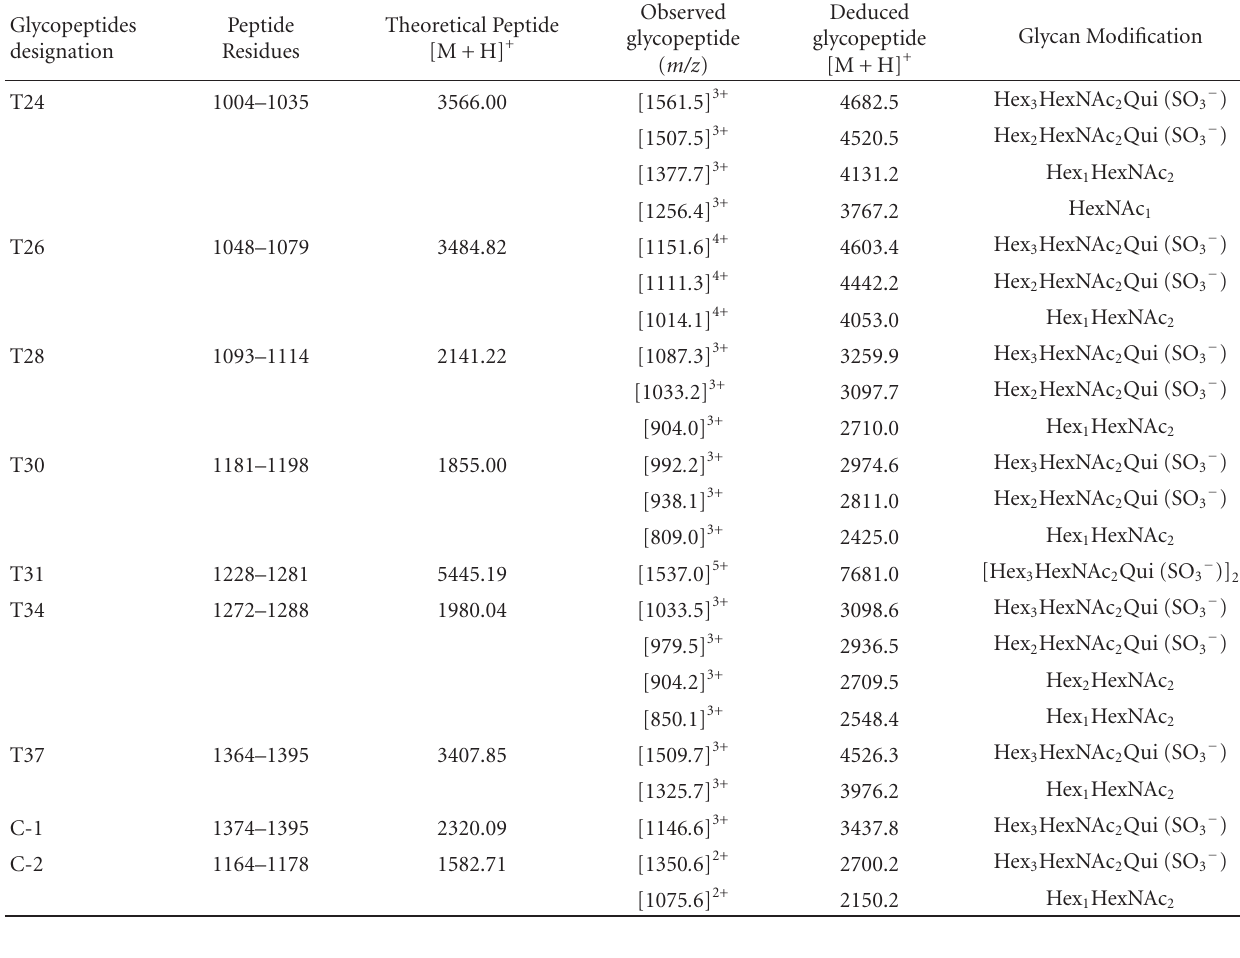
Table 1: Glycopeptides observed in LC-MS/MS analyses of proteolytic digests of the S-layer from S. acidocaldarius . Tryptic glycopeptides are designated T24, T26 and so forth based on the in silico digest shown in Figure 2. Two chymotryptic glycopeptides derived from the C-terminal domain of the S-layer are designated C-1 and C-2.